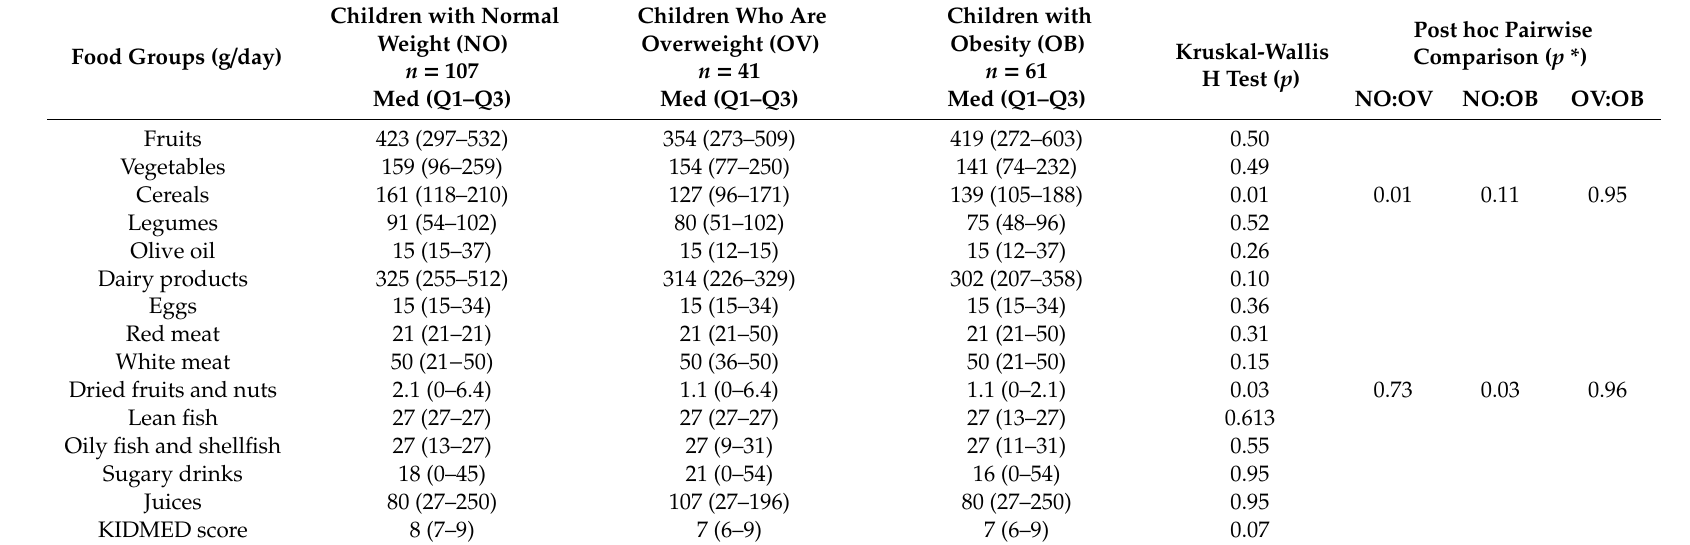
Table 1. Food group